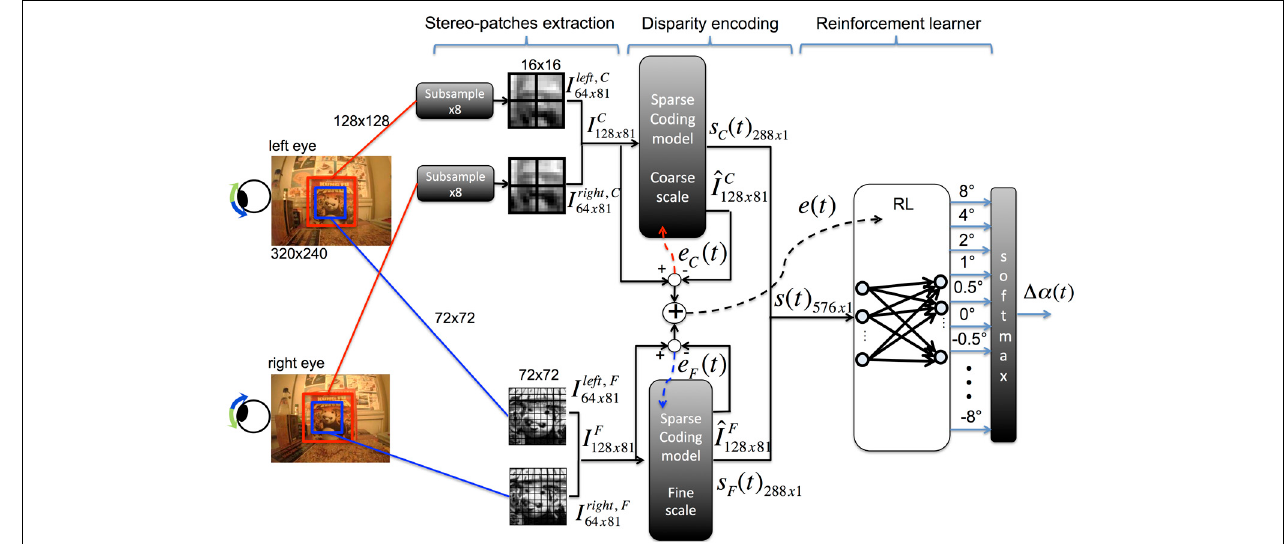
FIGURE 1 | Architecture of the model for vergence control [adapted from Lonini et al.